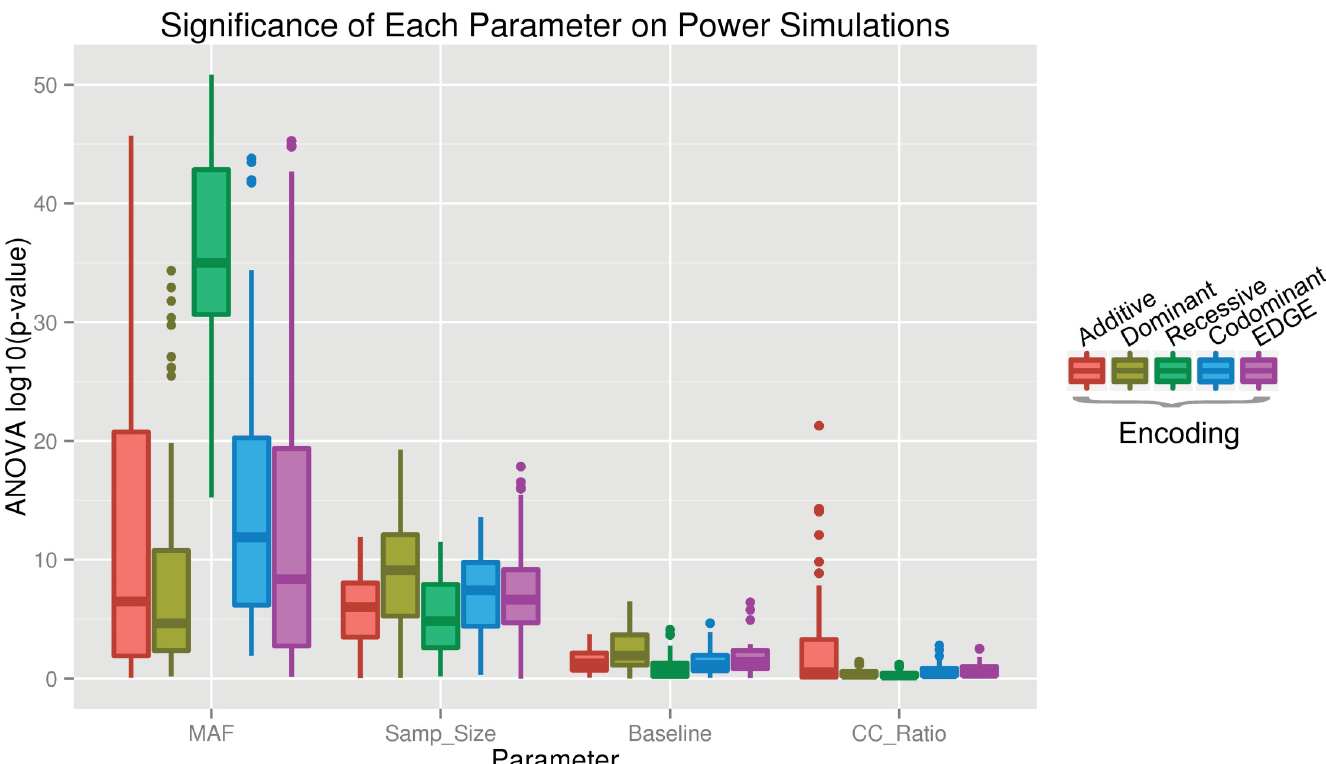
Fig 7. Significance of each parameter on power. ANOVA tests were performed to determine the impact of parameters MAF, sample size, baseline (penetrance), and case-control ratio on power for each interaction model for the additive (red), dominant (yellow), recessive (green), codominant (blue), and EDGE (purple) encodings.